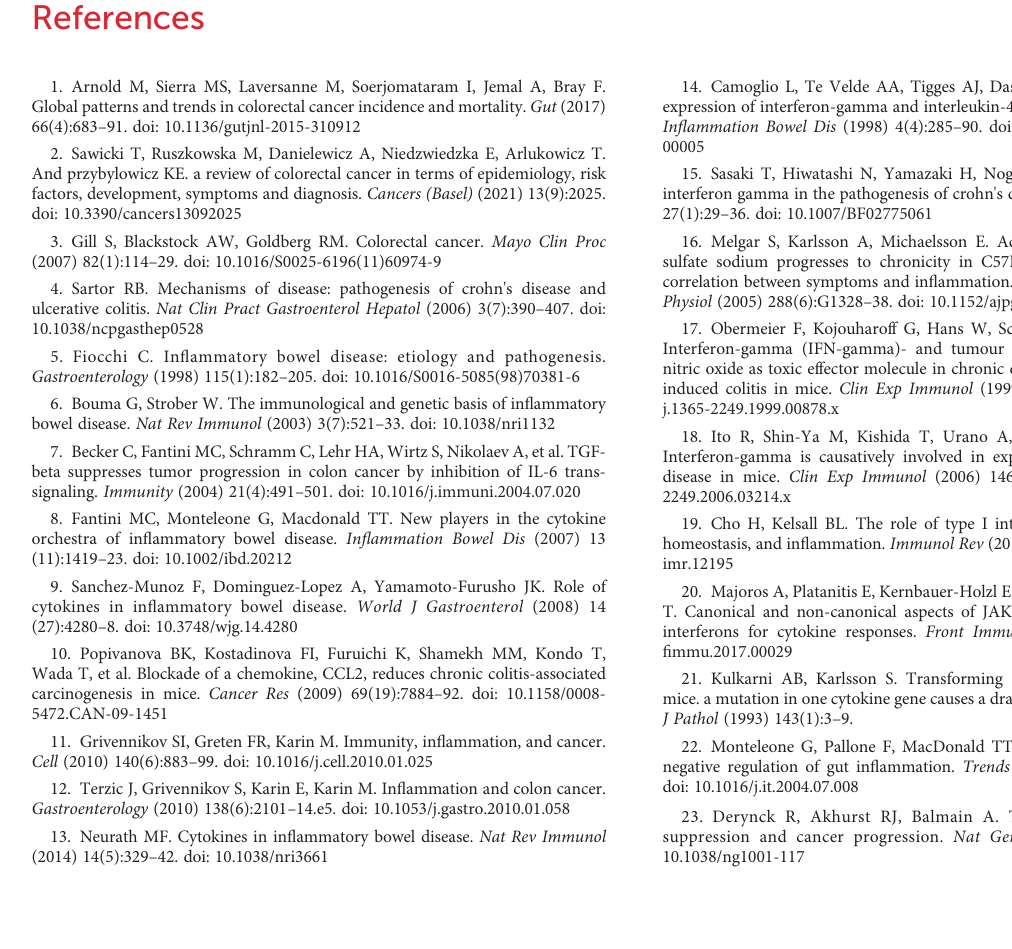
SUPPLEMENTARY FIGURE 1 Cell cycle analysis of CD4 T cells per genotype. CD4 T cells as mentioned in Figure 1D were incorporated with BrdU for the last 16 hrs incubation, harvested, intracellularly stained with anti-BrdU and 7AAD. SUPPLEMENTARY FIGURE 2 In fl ammatory cytokines and tumor suppressor in colitis associated colon cancer in Smad4 TKO mice. (A) Relative mRNA expressions of pro- in fl ammatory cytokines (IFN- g , TNF- a and IL-6) in colon mucosa of WT and Smad4 TKO mice at 8 months were measured by real time PCR (n=4- 6). (B) Pro-in fl ammatorycytokines,IFN- g andIL-6,incolonlaminapropria lymphocytes of WT and Smad4 TKO mice at 8 months were measured by fl ow cytometry. SUPPLEMENTARY FIGURE 3 Impaired TGF- b -induced Foxp3 + Treg (iTreg) in Smad4-de fi cient T cells. (A) Analysis of iTreg population in CD4 + T cell compartment of each genotype. Cells from spleen per genotype at 2 months of age were collected and incubated with anti-CD3/CD28 for 72 hrs with (closed bar) or without (open bar) TGF- b (2 ng/ml) and intracellularly stained with Foxp3 antibody. Results are representative of three independent experiments using pooled spleens from two mice per genotype. Bar graph of percent iTreg from each group. ** p < 0.01. SUPPLEMENTARY FIGURE 4 High expression of PD-L1 in the colon of Smad4TKO mice. (A) Immunohistochemistry (IHC) staining for PD-L1 in colons of each genotype were summarized in a bar graph with error bars. ***p <